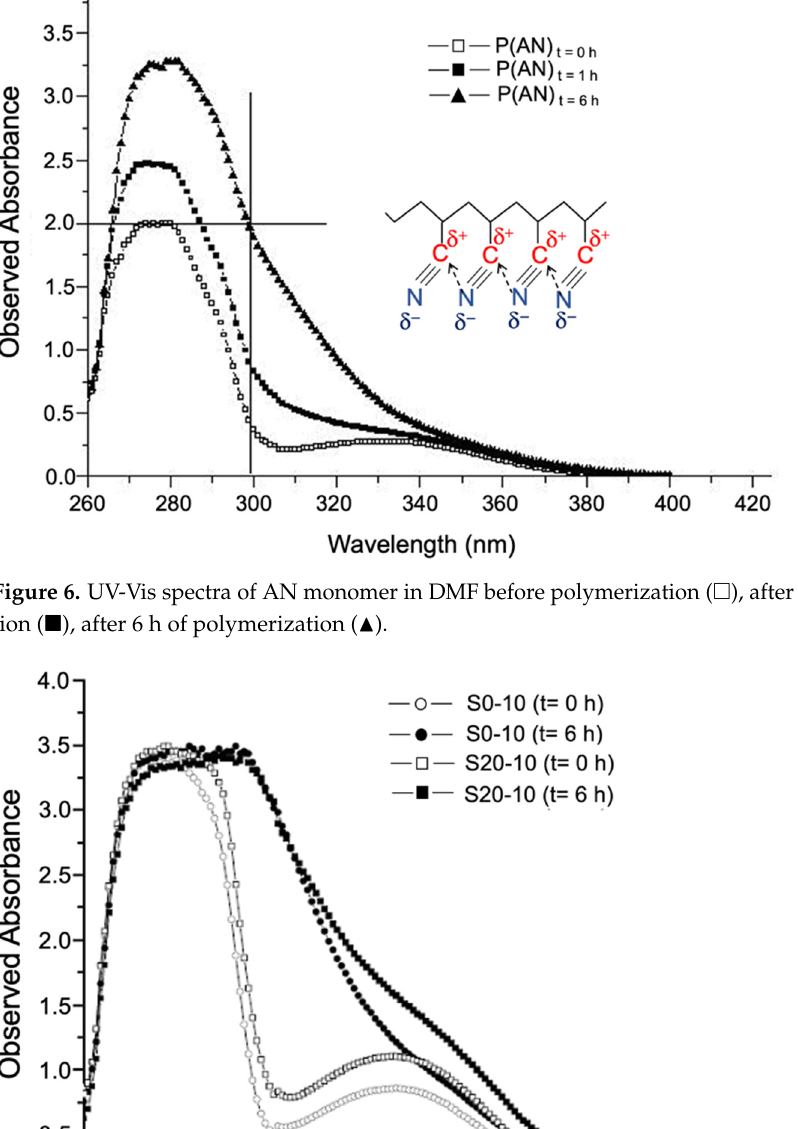
Figure 8. UV-Vis spectra of AN-GMA monomer mixture (with equimolar ratio) in DMF before polymerization ( □ ), after 1 h of polymerization ( ■ ), and after 6 h of polymerization ( ▲ ). Two copolymerization systems (i.e., S0-10 and S20-10) were selected to examine their UV-Vis spectra (Figure 7). The ~280 nm absorption is similar at the start of polymerization despite the fact that the quaternary feed presents a slightly broader band. In both systems, the absorption bands were broadened after polymerization for 6 h, indicating the for- mation of AN segments in the two ionomers. Different from the homo-polymerization of AN, the ~280 nm intensity is practically unchanged. This is indicative of a negligible change in the number of AN association groups after polymerization, as defined above. On the other hand, the copolymerization increases the average alignment extent of AN